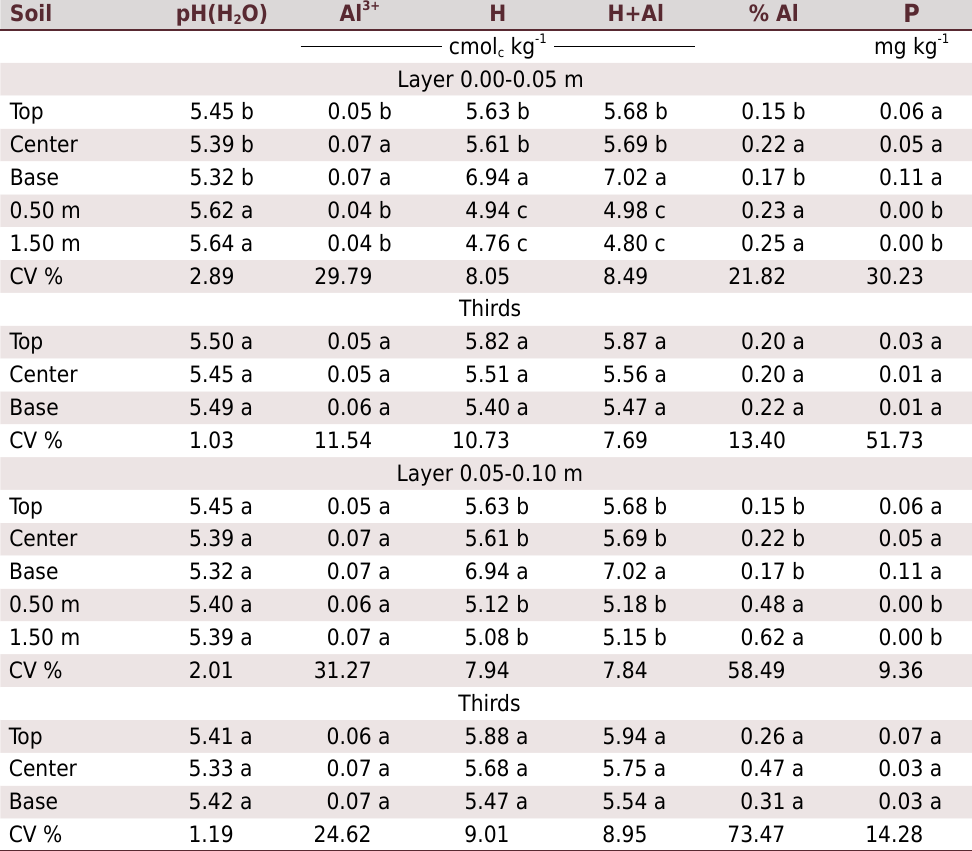
Table 3. Chemical properties of termite mounds and surrounding soils in the 0.00-0.05 and 0.05- 0.10 m layers, Mar de Morros , municipality of Pinheiral, Rio de Janeiro State Soil pH(H 2